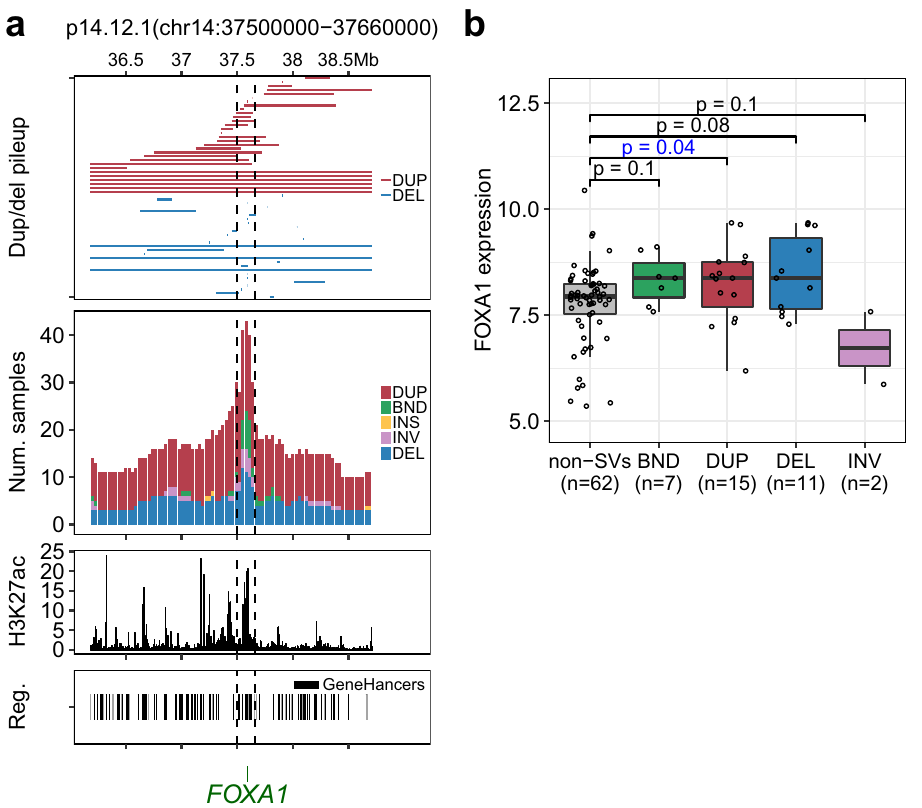
Figure 4. SV-HotSpot detects recurrent SVs targeting FOXA1 locus. ( a ) Visualization of FOXA1 locus. From top to bottom are pileup of duplication/deletion, aggregation of sample counts for different SV types, H3K27ac ChiP-Seq coverage from primary prostate cancer patients, enhancer annotation from GeneHancers. ( b ) Comparison of FOXA1 expression between samples harboring SVs and those do not (restricted to samples in which FOXA1 is copy